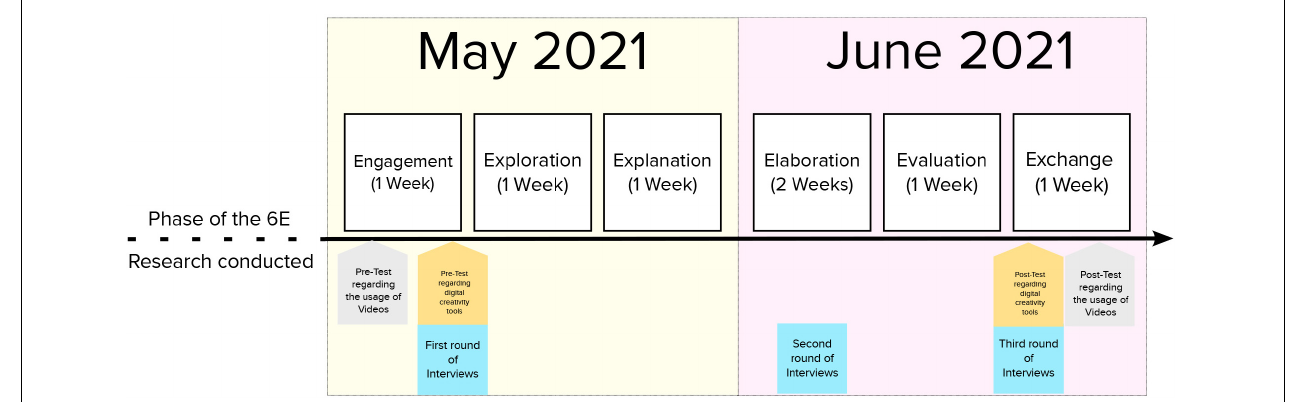
FIGURE 2 | Research